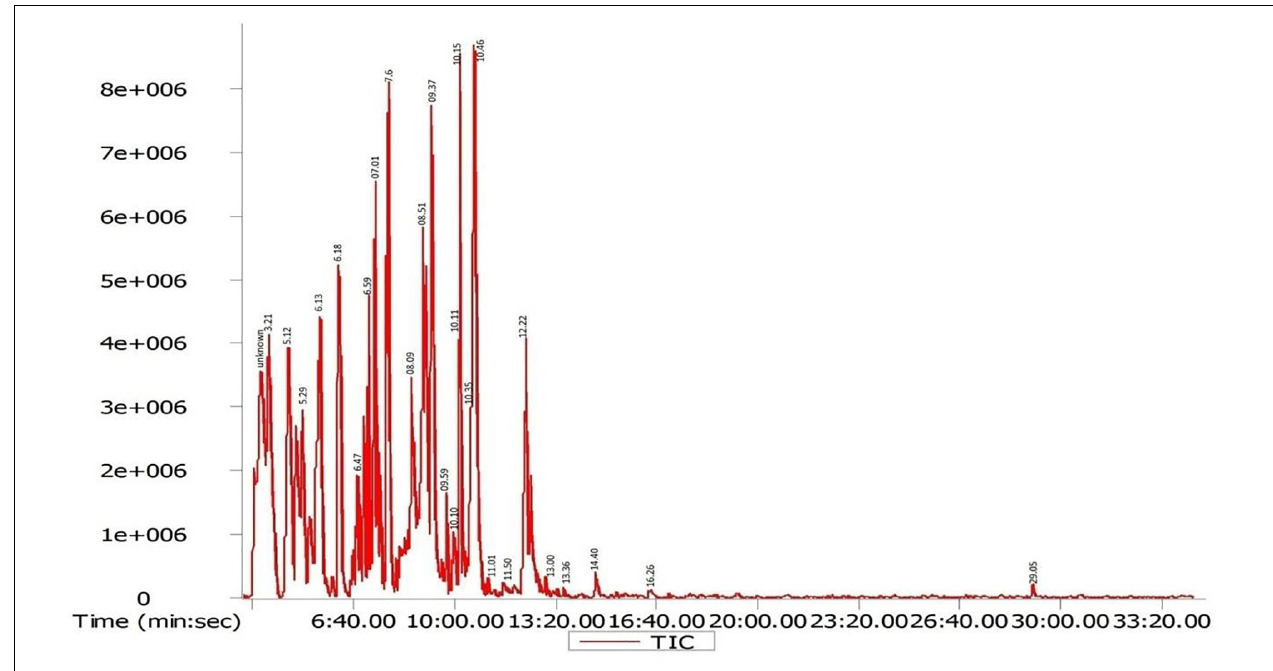
FIGURE 8 | GC-MS chromatogram of different secondary metabolites identified in the crude secondary metabolite extract of D. radiodurans .